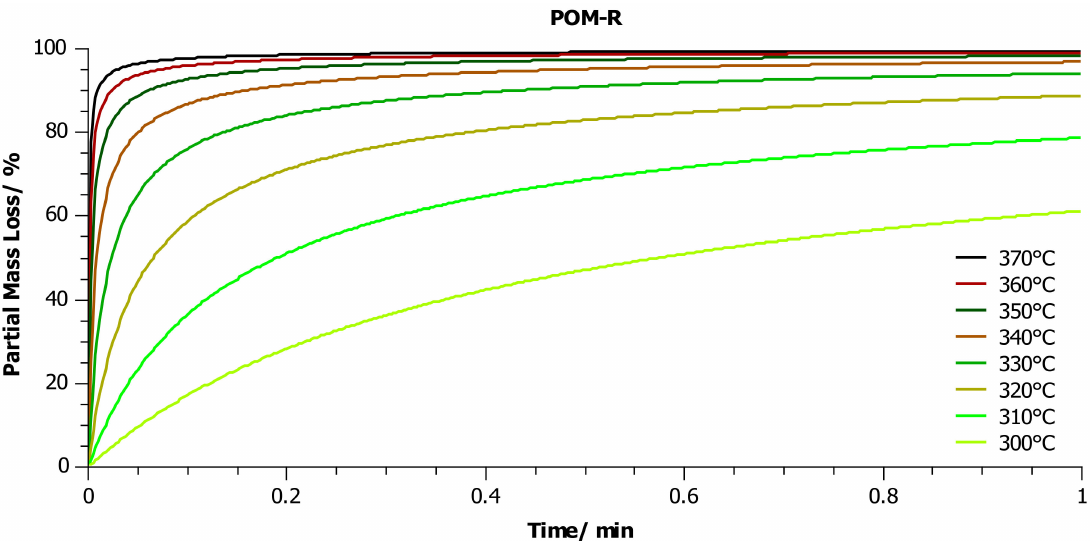
Figure 10. Prediction of the partial mass loss during heating in the temperature range 300–370 ◦ C in an oxygen atmosphere. The simulation was performed for the kinetic model of the POM-R sample, which was characterized by the best fit to the experimental results (Table 5).